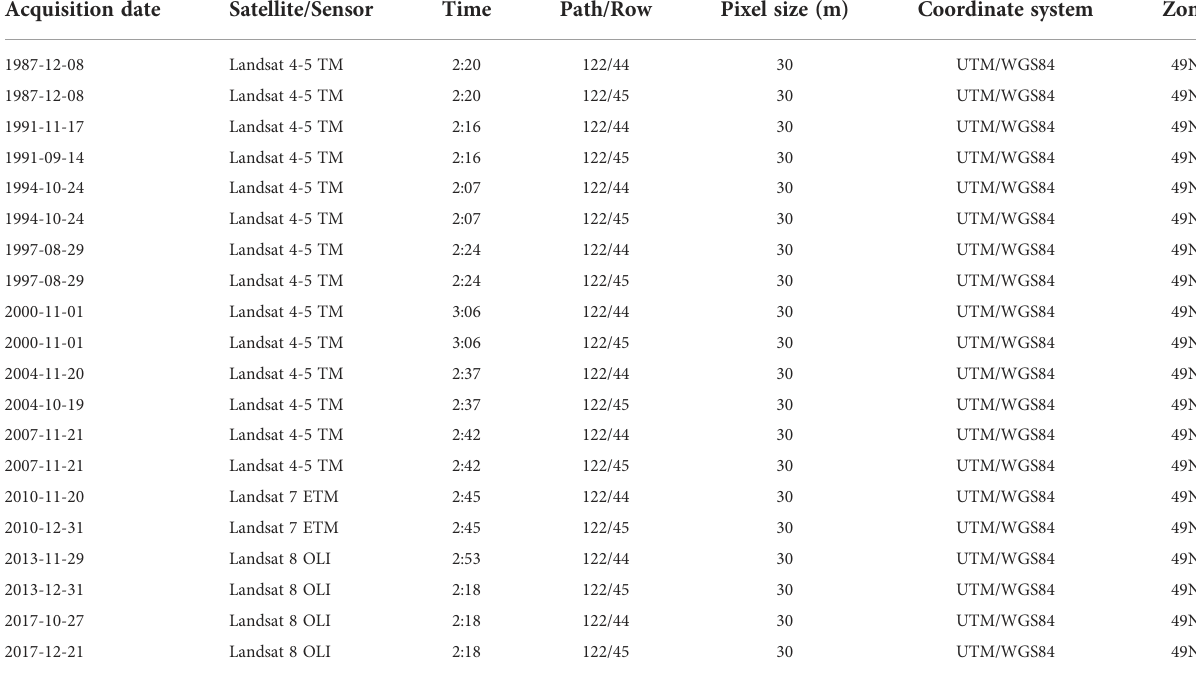
TABLE 1 Information on the selected remote sensing images from 1987 to